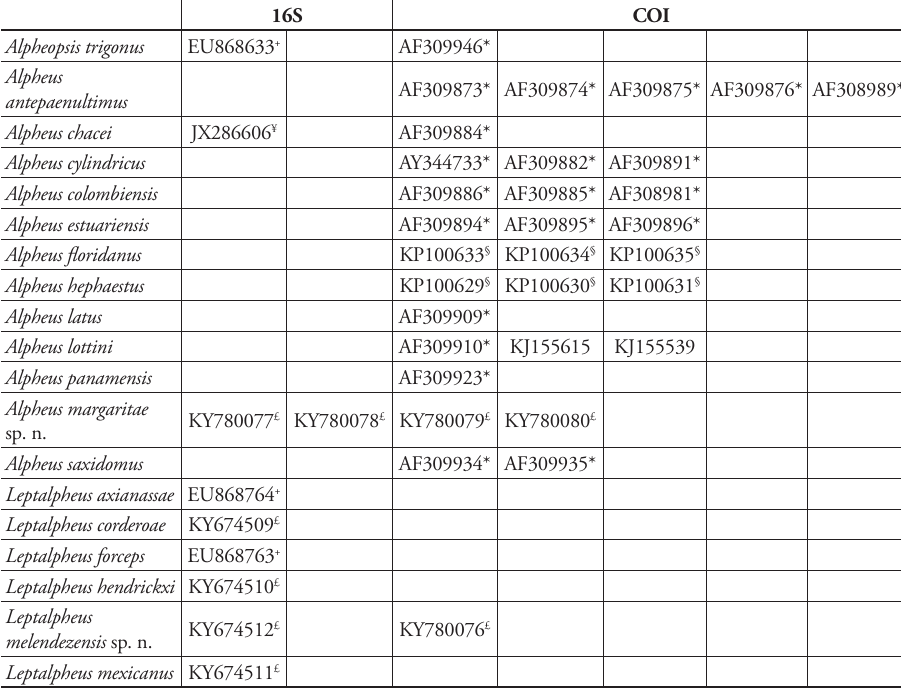
Table 1. Sequence data of Alpheus and Leptalpheus species, voucher number, and Genbank